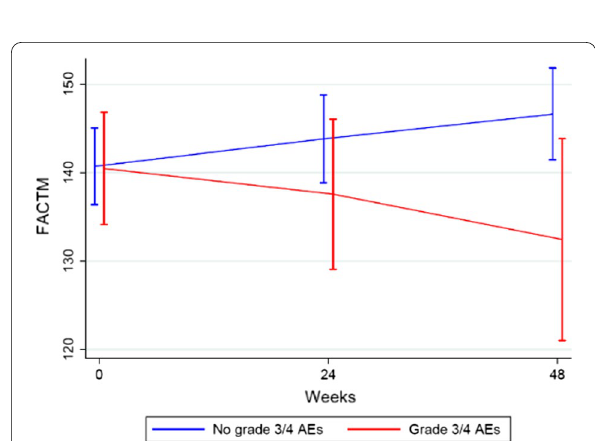
Fig. 4 FACT-M data for patients in the PROMelanoma study at baseline, week 24 and week 48, comparing the HRQoL between patients with no severe irAEs and patients with severe